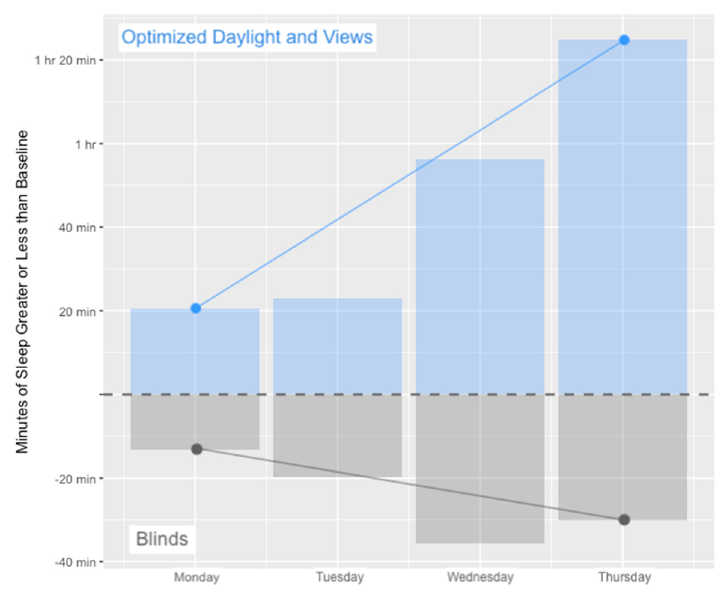
Figure 4. Visualization of the acute (Monday) effect and cumulative (Monday through Thursday) effect of the test conditions on sleep duration, relative to the participant’s measured baseline sleep.